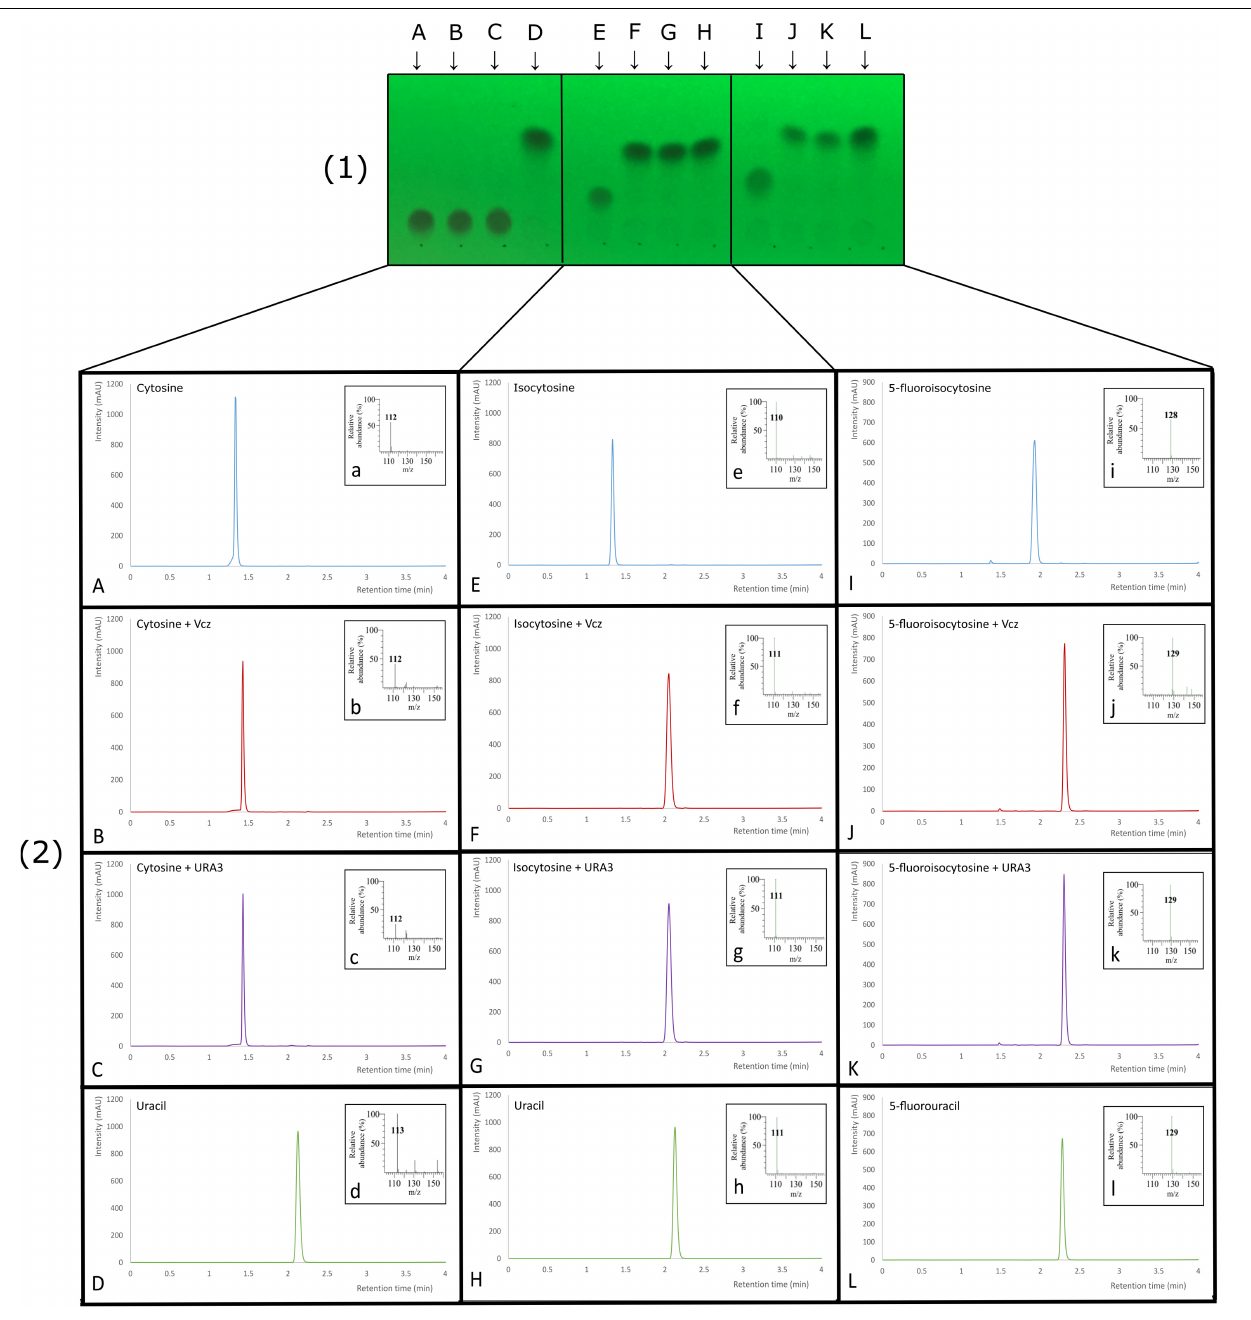
Frontiers in Microbiology |